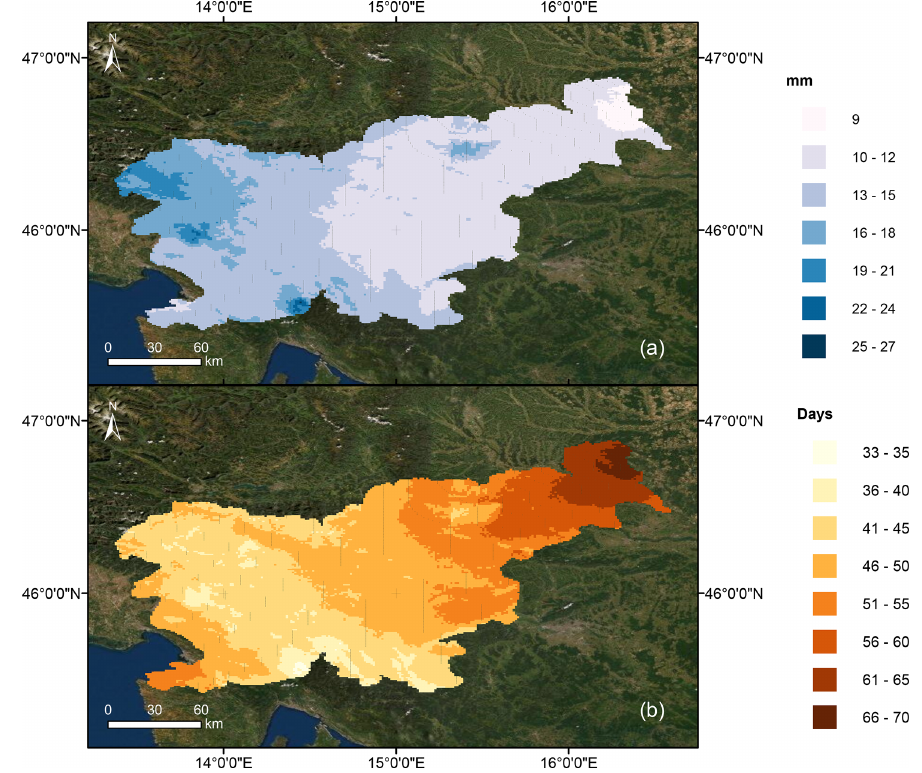
Figure 8. Daily precipitation indices: (a) SDII – daily precipitation intensity; (b) CDD – maximum number of consecutive dry days (Esri, 2020; GISCO, 2020).